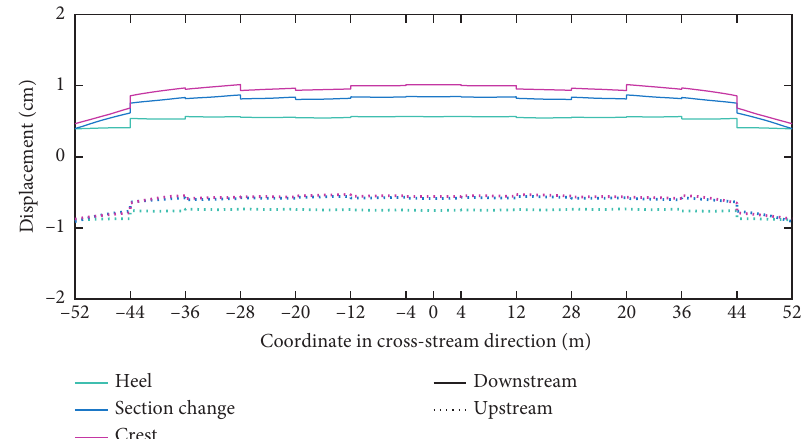
Figure 21: Maximum envelope of displacement in the stream direction induced by the Swedish design earthquake with only stream vibration.